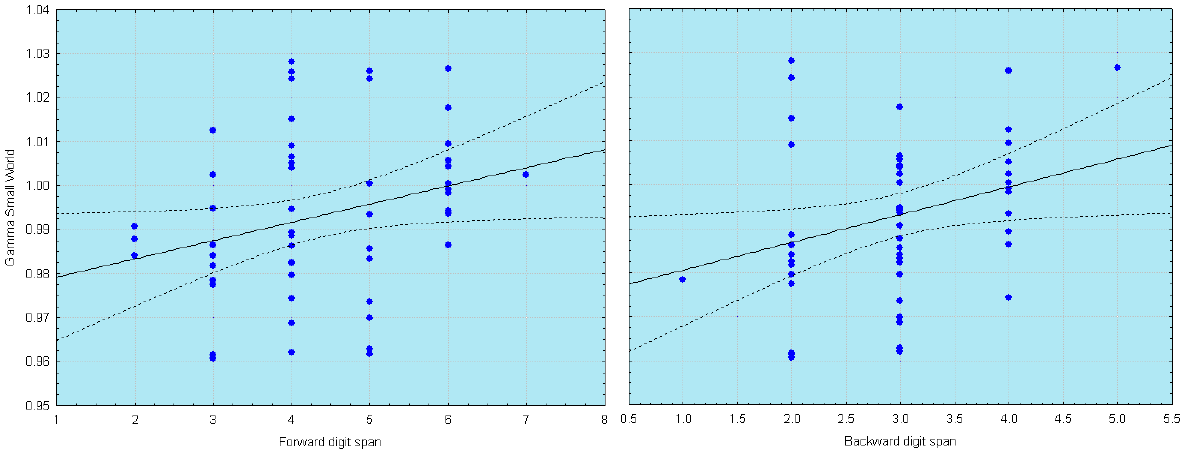
Figure 2. Scatterplots of SW index correlation with memory tasks. Less ordered brain network (as reflected by increasing value of SW) in the gamma band is associated with better memory performance. Adapted from [48].